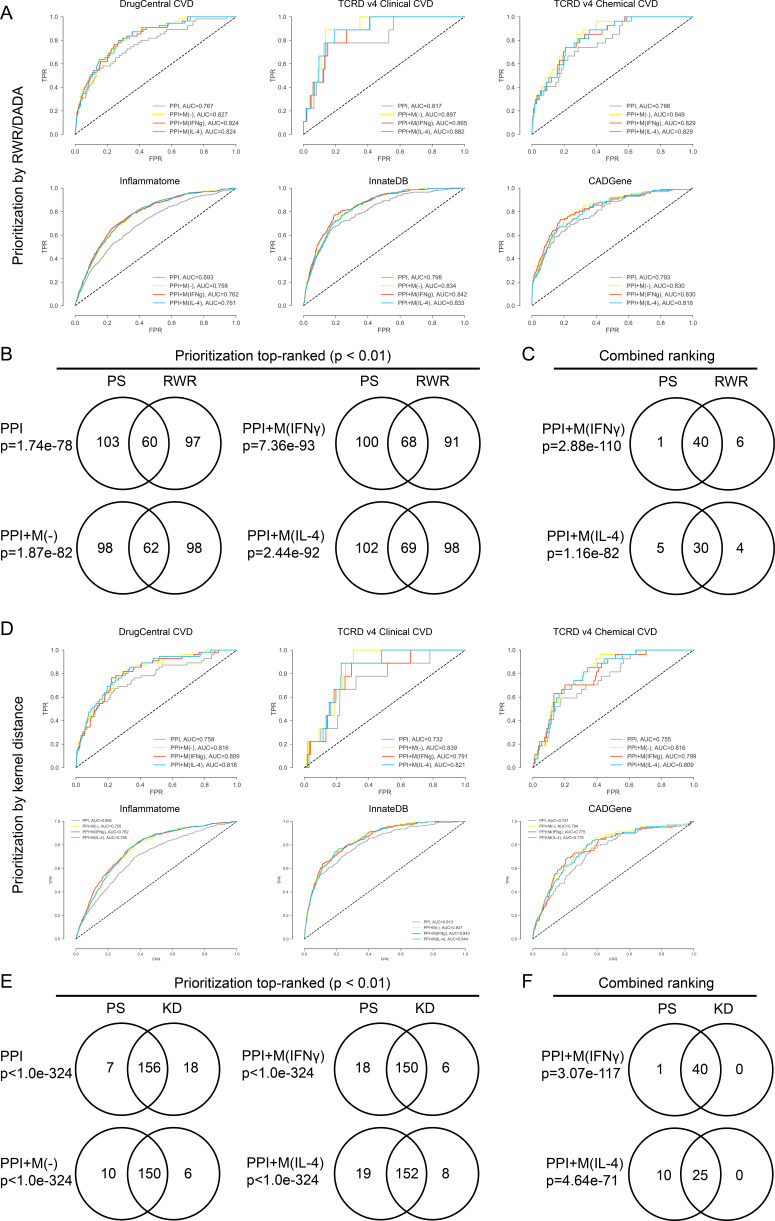
(A) ROC curves for PPI, PPI + M(-), PPI + M(IFNγ) and PPI + M(IL-4) for the validations sets, where random walk with restarts (RWR) was used as the prioritization method. (B) Venn diagrams showing the overlap in terms of the top-ranked candidates between the two cases where RWR and PS (shortest distance based proximity score used in this study) were used as the prioritization method to rank candidates. Results are shown for the non-optimized case. Fisher’s exact test was used and two-sided p-values were reported. (C) Venn diagrams showing the overlap in terms of the final combined ranking between the two cases where RWR and PS were used as the prioritization method to rank candidates. Results are shown for the non-optimized case. Fisher’s exact test was used and two-sided p-values were reported. (D) ROC curves for PPI, PPI + M(-), PPI + M(IFNγ) and PPI + M(IL-4) for the validations sets, where random walk with restarts (RWR) was used as the prioritization method. (E) Venn diagrams showing the overlap in terms of the top-ranked candidates between the two cases where KD (kernel distance) and PS (shortest distance measure used in this study) were used as the prioritization method to rank candidates. Results are shown for the non-optimized case. Fisher’s exact test was used and two-sided p-values were reported. (F) Venn diagrams showing the overlap in terms of the final combined ranking between the two cases where KD and PS were used as the prioritization method to rank candidates. Results are shown for the non-optimized case. Fisher’s exact test was used and two-sided p-values were reported.